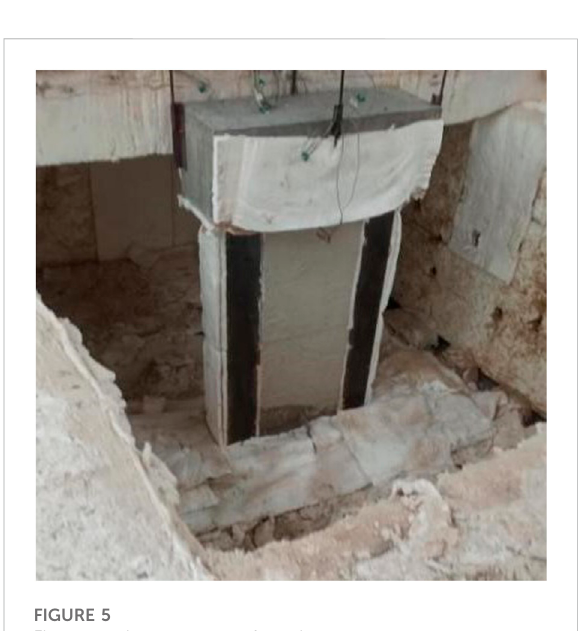
FIGURE 5 Fire protection treatment of